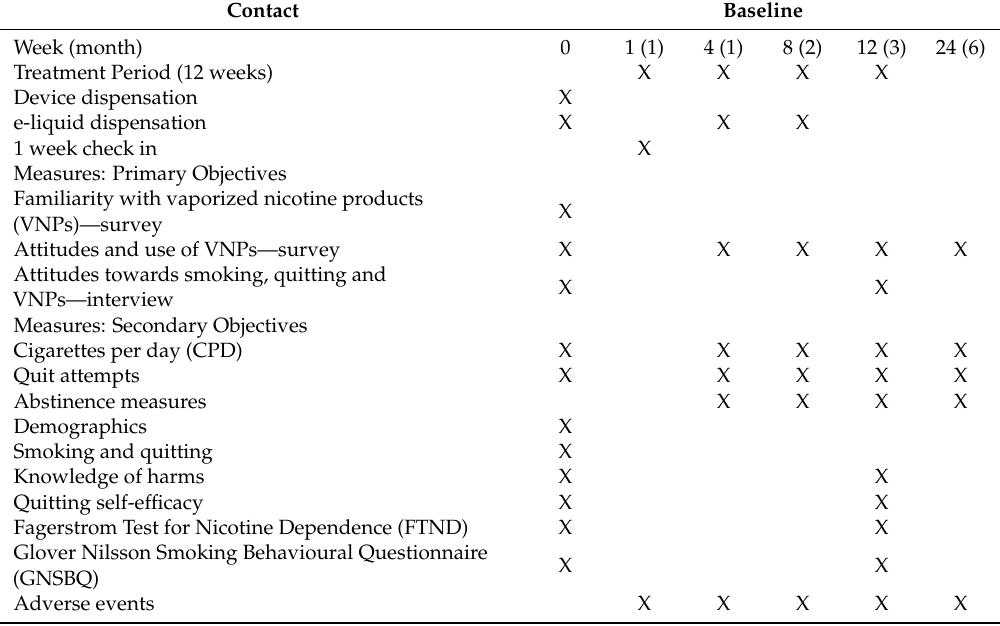
Table 1. Schedule of